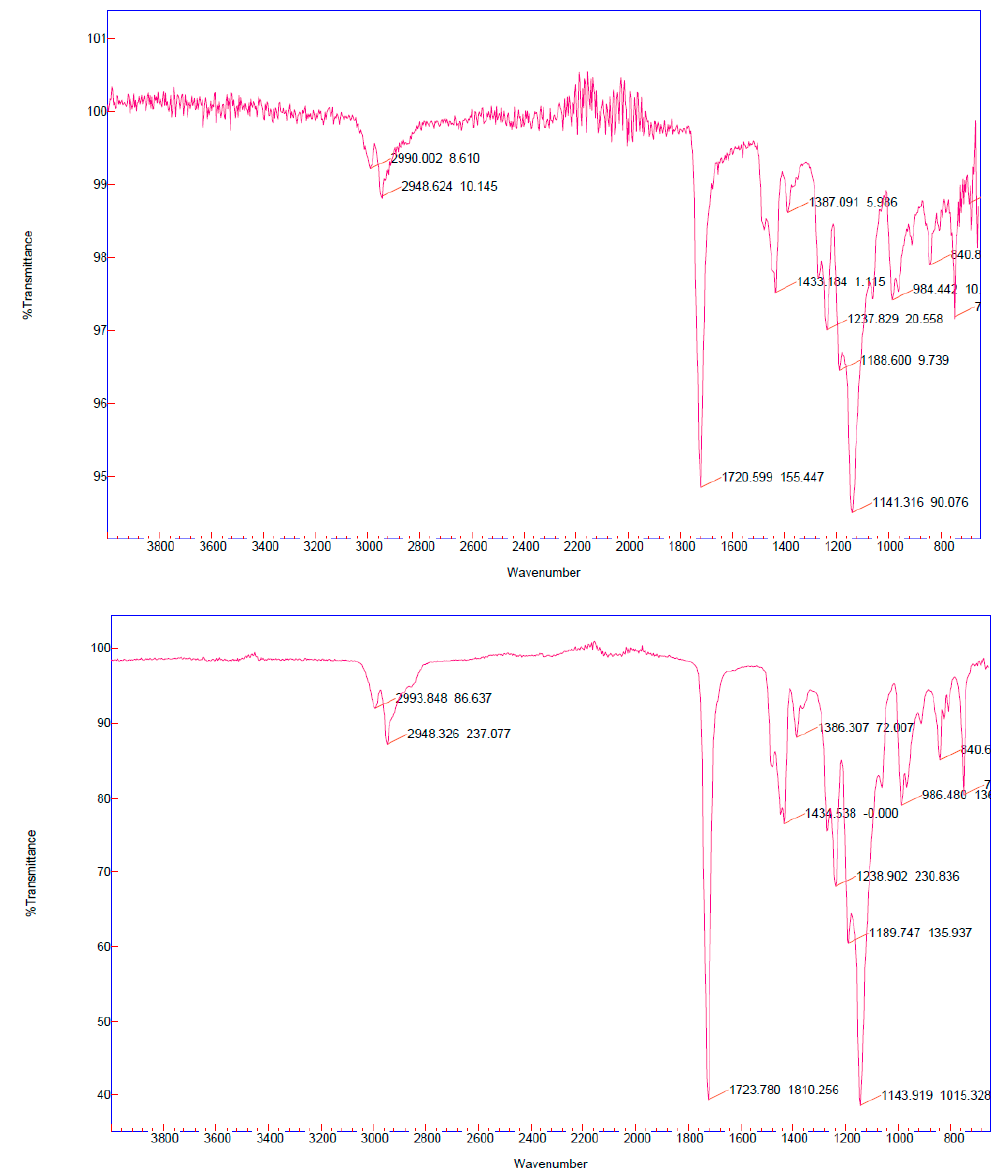
Figure 7. FTIR spectrometry: image of final polymer product of the E2 run ( top ) and the E4 run ( bottom ) using the 4,4 ′ -Dinonyl-2,2 ′ -dipyridyl (dNbpy) ligand for a sample collected after 3 h of polymerization initiation.